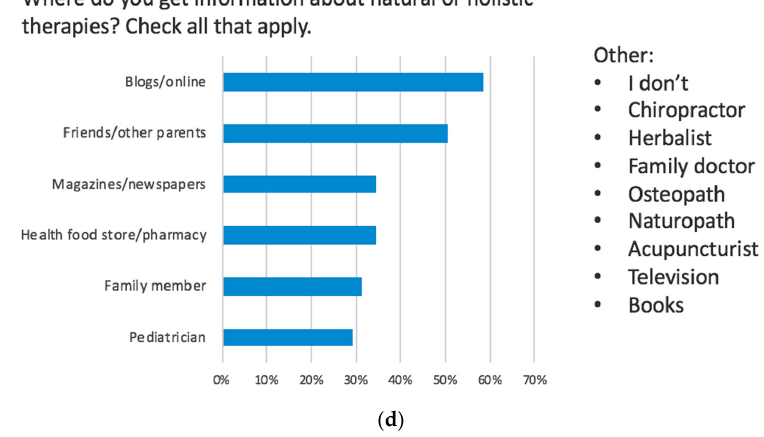
Figure 3. ( a ) Parent response to question “how familiar are you with integrative or holistic medicine?”